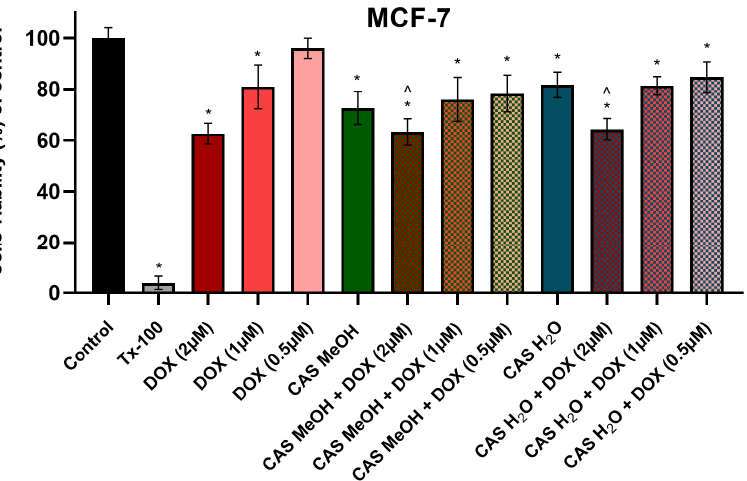
Figure 8. MCF-7 breast cancer cell viability (% of control) based on MTT assay. Cells were treated for 48 h with 2–0.5 µ M of DOX and 125 µ g/mL of CAS H 2 O or 125 µ g/mL of CAS MeOH, or